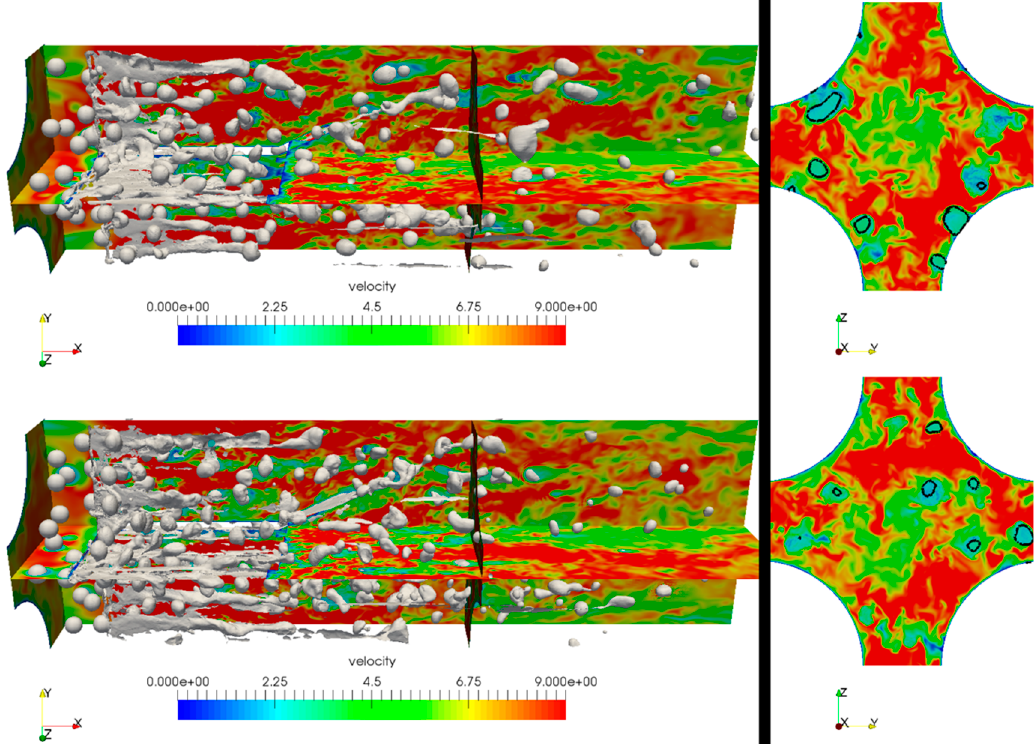
Figure 2. Instantaneous state of droplets and velocity contours for the We40 ( top ) and We80 ( bottom ) case at t = 14.75 and 13.35 ms, respectively. Note that gravitational body force acts along the negative x coordinate.